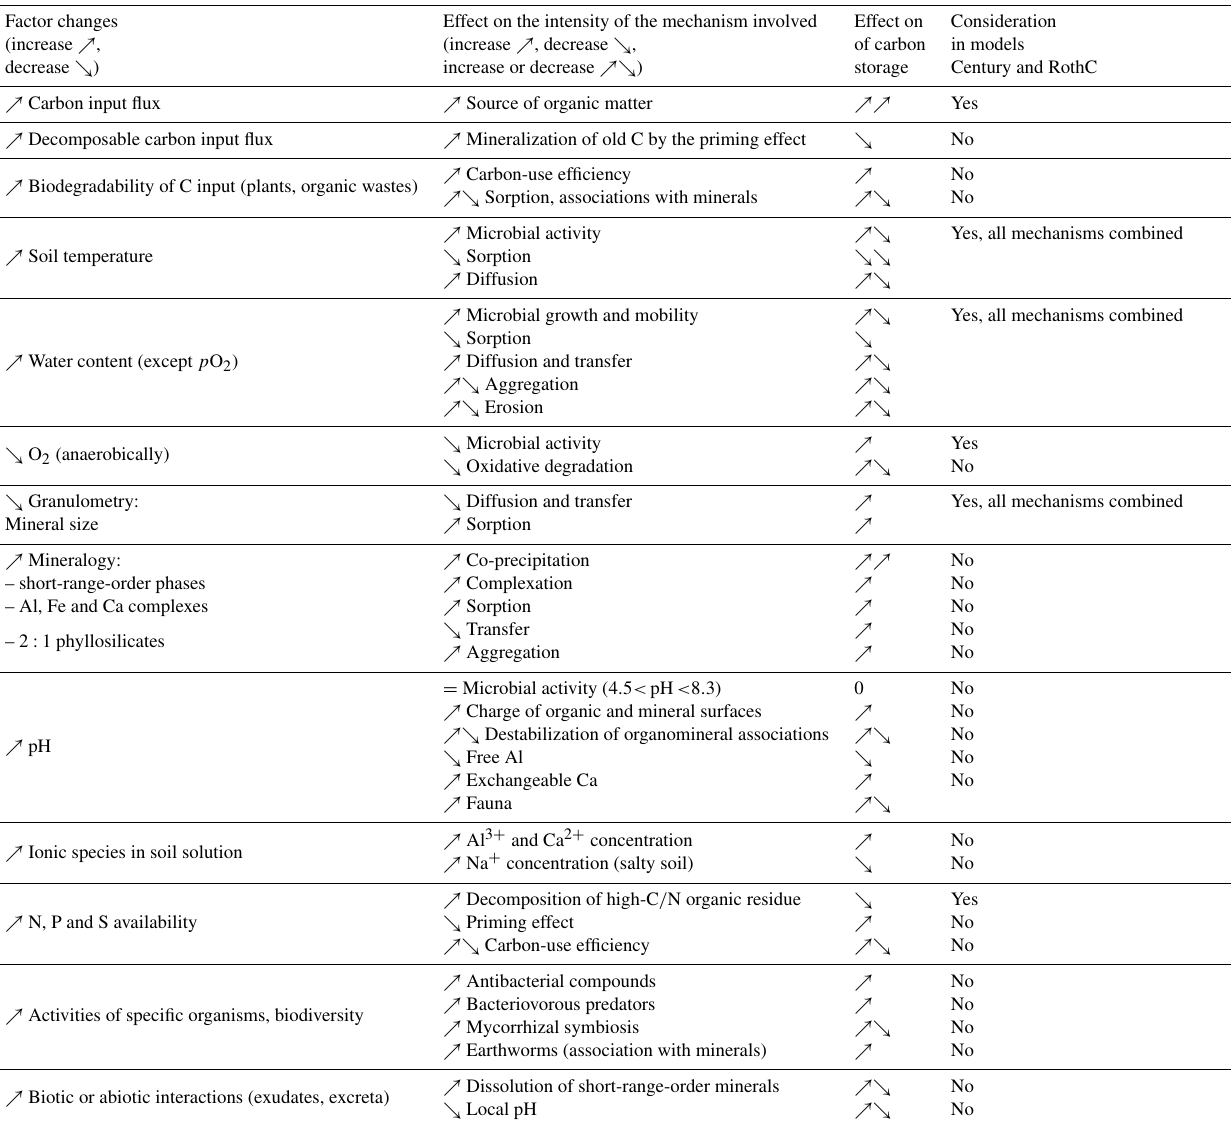
Table 2. Mechanistic analysis of factors influencing the carbon turnover time in soil (Fontaine et al., 2011; Schmidt et al., 2011; Kallenbach et al., 2016; Sinsabaugh et al., 2013; Rasmussen et al., 2018; Northup et al., 1995; Averill et al., 2014; Keiluweit et al., 2015; Bonneville et al., 2011). References for RothC and Century are Coleman et al. (1997) and Parton and Rasmussen (1994), respectively. Factor changes Effect on the intensity of the mechanism involved Effect on of